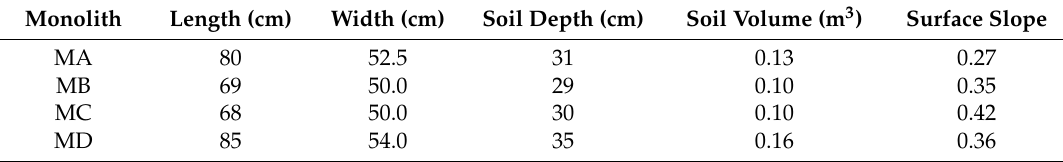
Table 1. Dimensions of the soil monoliths sampled in the drainage experiments.